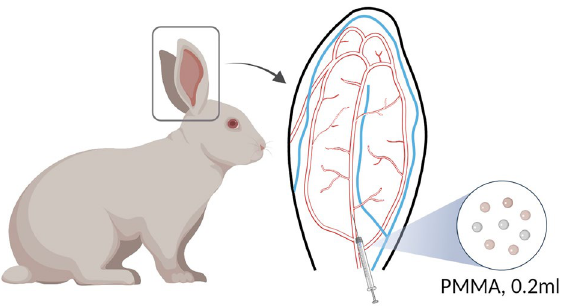
Figure 1. Schematic diagram of intravascular injection in the rabbit ear. Injection site: approximately 1 cm above the bifurcation of the auricular artery. Figure was created on BioRender (https:// biore nder. com/) and in Procreate application (version 5.2.6; https:// procr eate.